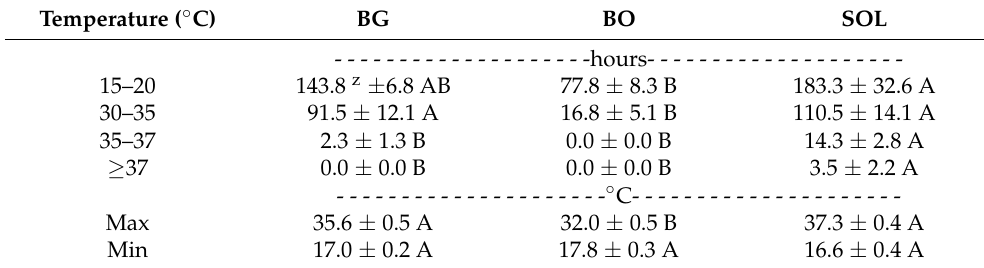
Table 2. Effects of pre-plant treatments on hours of soil temperature ranges during the corn crop phase in no-till black oat (BO), bare ground (BG), and solarization (SOL) plots. Temperature ( ◦